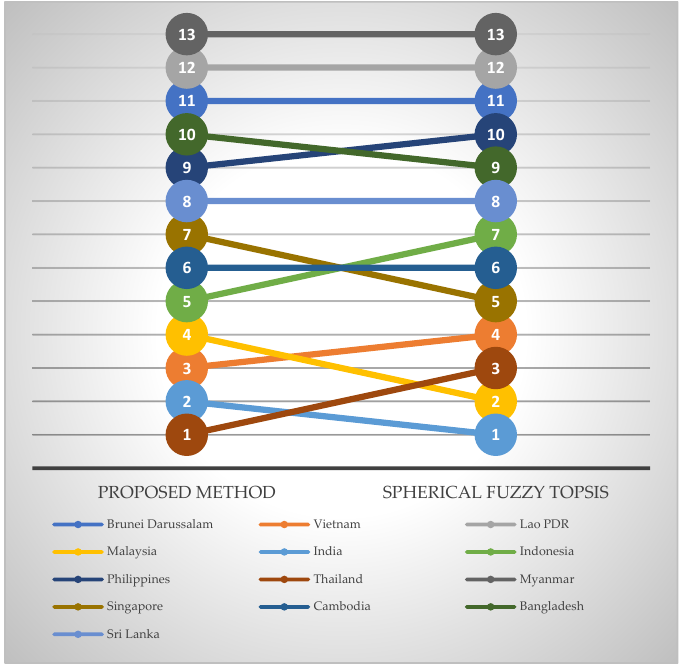
Figure 10. Comparison analysis with another distance-based MCDM method.